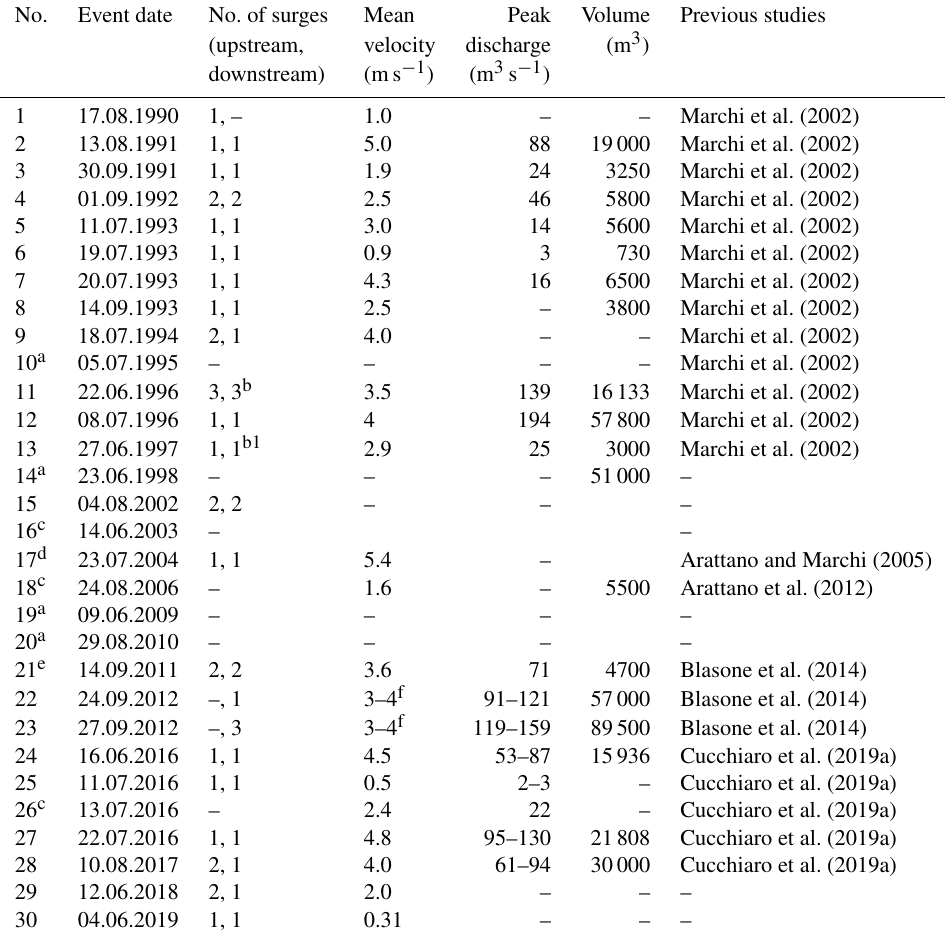
Table 2. Debris-flow data; the mean velocity refers to the main surge.